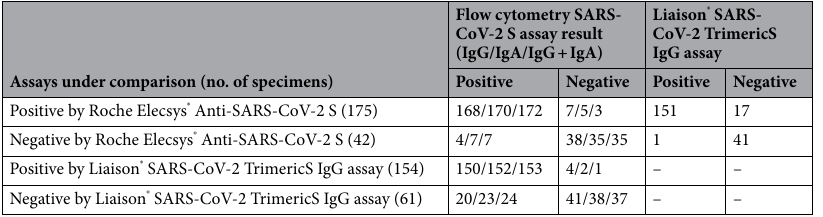
Table 1. Performance comparison between a flow cytometry-based S immunoassay and two commercially- available SARS-CoV-2 chemiluminescent immunoassays. RBD receptor binding domain, S spike protein.